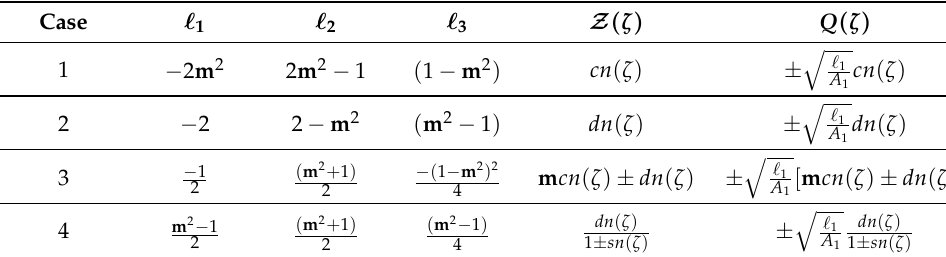
Table 4. All possible solutions for wave Equation (12) when (cid:96) 1 < 0. Case